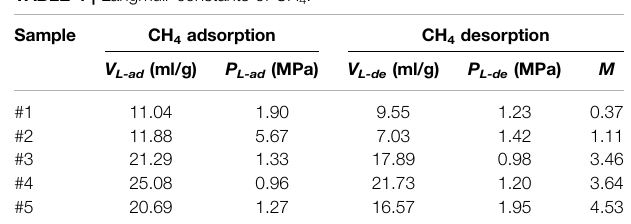
TABLE 3 | Langmuir constants of CO 2 . TABLE 4 | Langmuir constants of CH 4